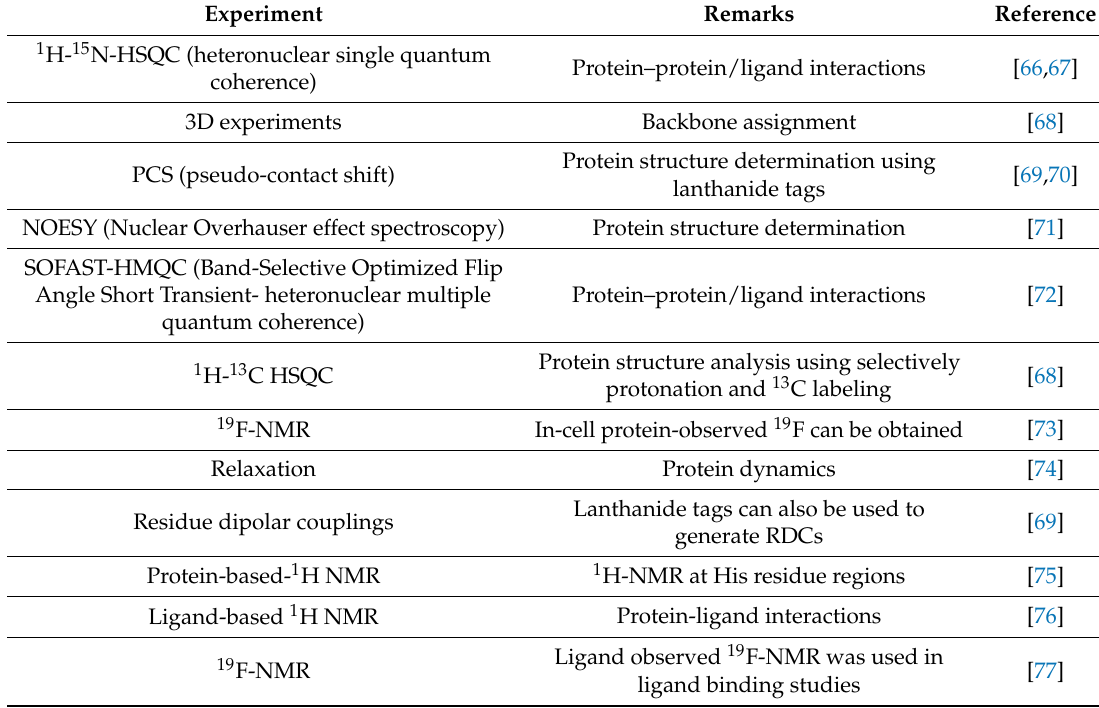
Table 1. Some types of experiment used in in-cell NMR studies a .